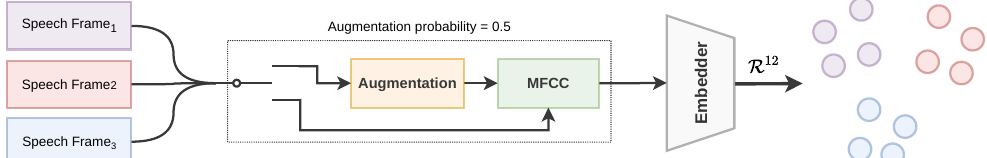
Figure 3. The training of both pairwise and triplet networks is done through the same data processing pipeline. Half of the inputs are randomly augmented and processed using MFCC. The MFCC of each frame is further passed to the DL